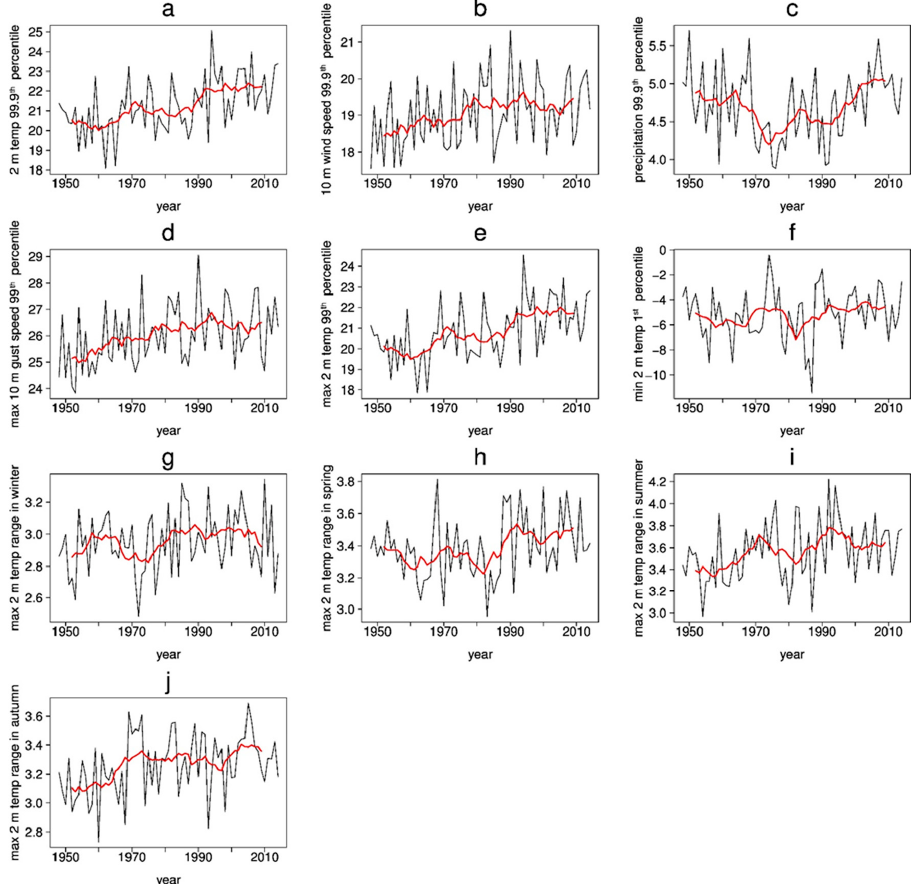
Figure 7. GB0028 time series for 67 years (black) with 10 years running mean (red) of ( a ) annual 99.9th percentile of 2 m temperature, ( b ) annual 99.9th percentile of 10 m wind speed, ( c ) annual 99.9th percentile of precipitation, ( d ) annual 99th percentile of maximum 10 m gust speed, ( e ) annual 99th percentile maximum 2 m temperature, ( f ) annual 1st percentile of minimum 2 m temperature, ( g ) maximum 2 m temperature range in winter, ( h ) maximum 2 m temperature range in spring, ( i ) maximum 2 m temperature range in summer, ( j ) maximum 2 m temperature range in autumn.